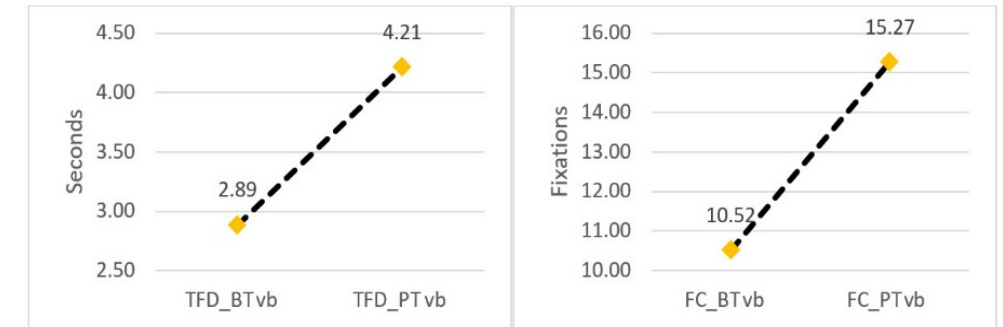
Figure 2. Marginal means of total duration of fixations and number of fixations in ads showing single bottles and packs of white wine.